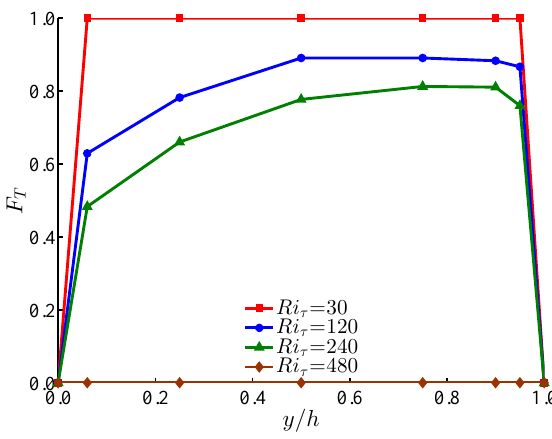
Figure 12. Vertical distribution of turbulent fraction ( F T ) with dif- ferent Ri τ ( Re τ =